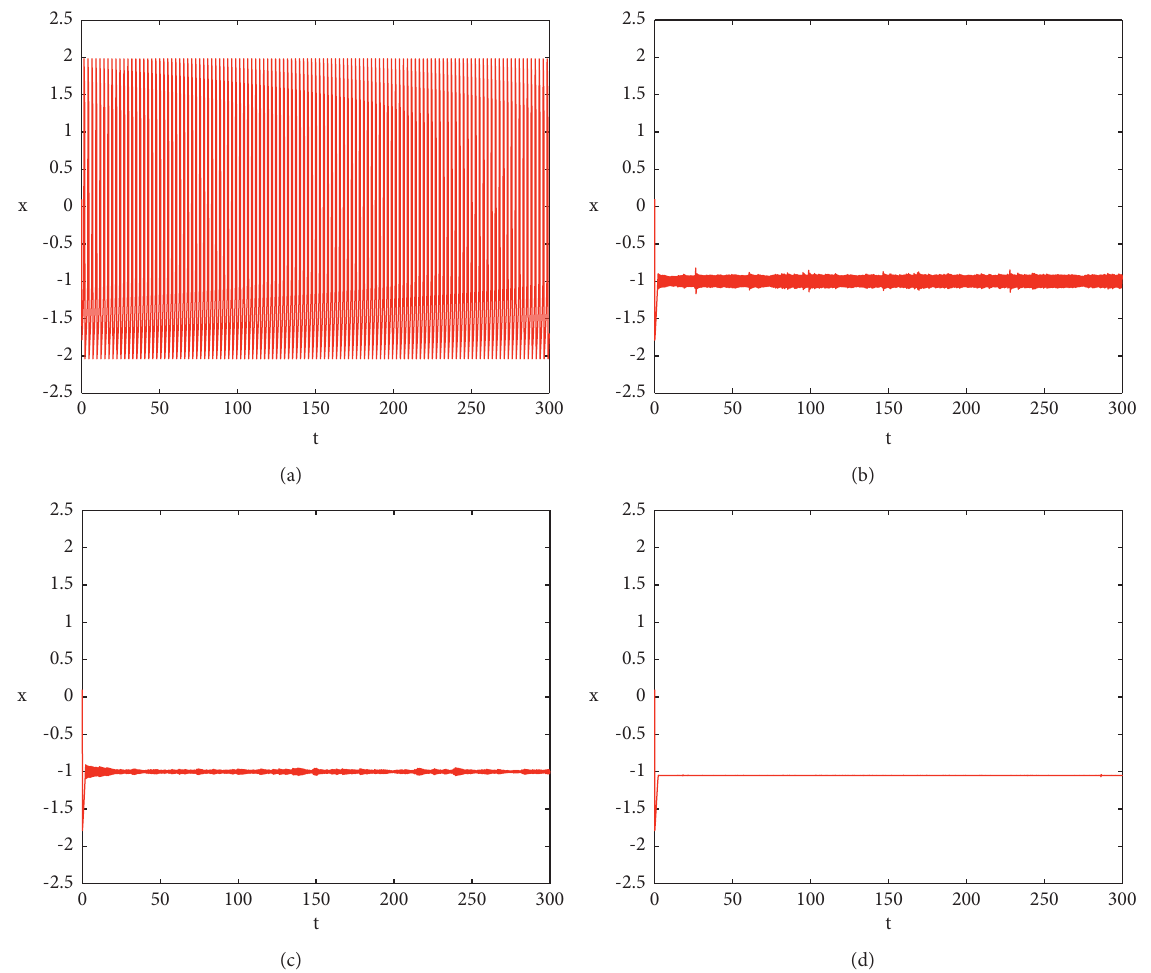
Figure 2: The temporal evolution of neuronal membrane potential in FHN with different parameters of a . (a) a � 0 . 8; (b) a � 1 . 0; (c) a � 1 . 0005; (d) a � 1 . 05.